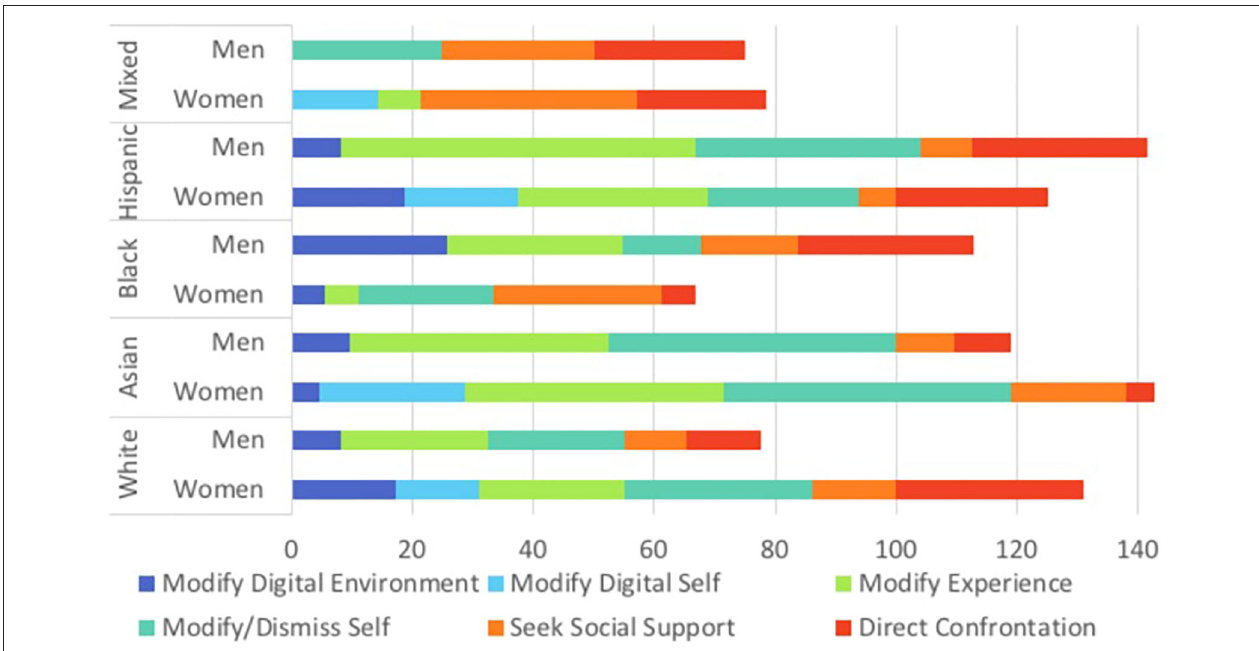
FIGURE 1 | Superordinate strategies for coping with discriminatory acts, by race and gender. Endure/ignore strategy is not included as it dominated the approaches (see Table 2 ) and was often the initial strategy reported. The bar length shows the percentage of participants, identifying by race and gender category, reporting each strategy. The counts exceed 100% as the participants reported multiple coping styles. The counts were normalized by the number of participants in each identity group, allowing inter- and intra-identity factor